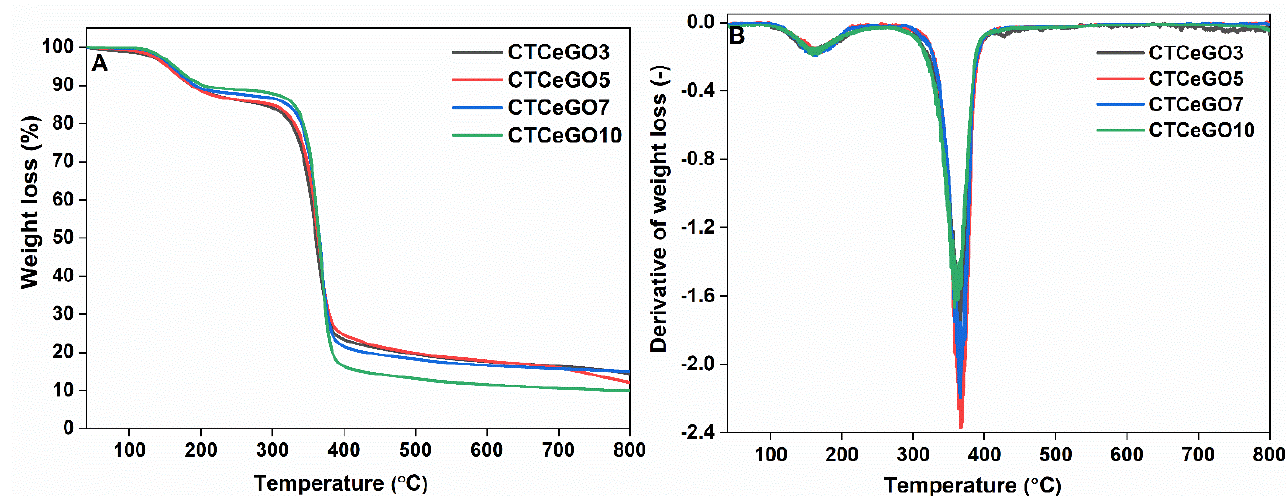
Figure 6. ( A ) TGA, and ( B ) its corresponding DTG plot of the synthesized MMMs. Representative strain-stress curves of the synthesized MMMs showing the loading effect is depicted in Figure 7. The stress-strain curves of each sample were chosen from their corresponding data sets that are closest to their respective averages reported in Table 1. Young’s modulus increases with an increase in GO concentration, indicating the significant effect of GO on mechanical strength. The tensile strength, which characterizes sample stiffness, increases with an increase in the concentration of GO in the matrix up to 7 wt.% then after decrease at higher concentration of GO whereas elongation at maximum stress decreases. Agglomeration in the high loading of GO can be the reason for the reduction in tensile strength. Compared to pristine CTA [25], the elongation at break decreased with the addition of the hybrid fillers attributed to the rigidification of the polymer chain mainly due to favourable interaction between the polymer matrix and the nanofillers [38]. The decrease in elongation at break and increase in Young’s modulus with the increase in GO concentration manifests the role of GO in fortifying interfacial interaction and improving interfacial quality of CeO 2 @GO hybrid fillers containing MMMs.